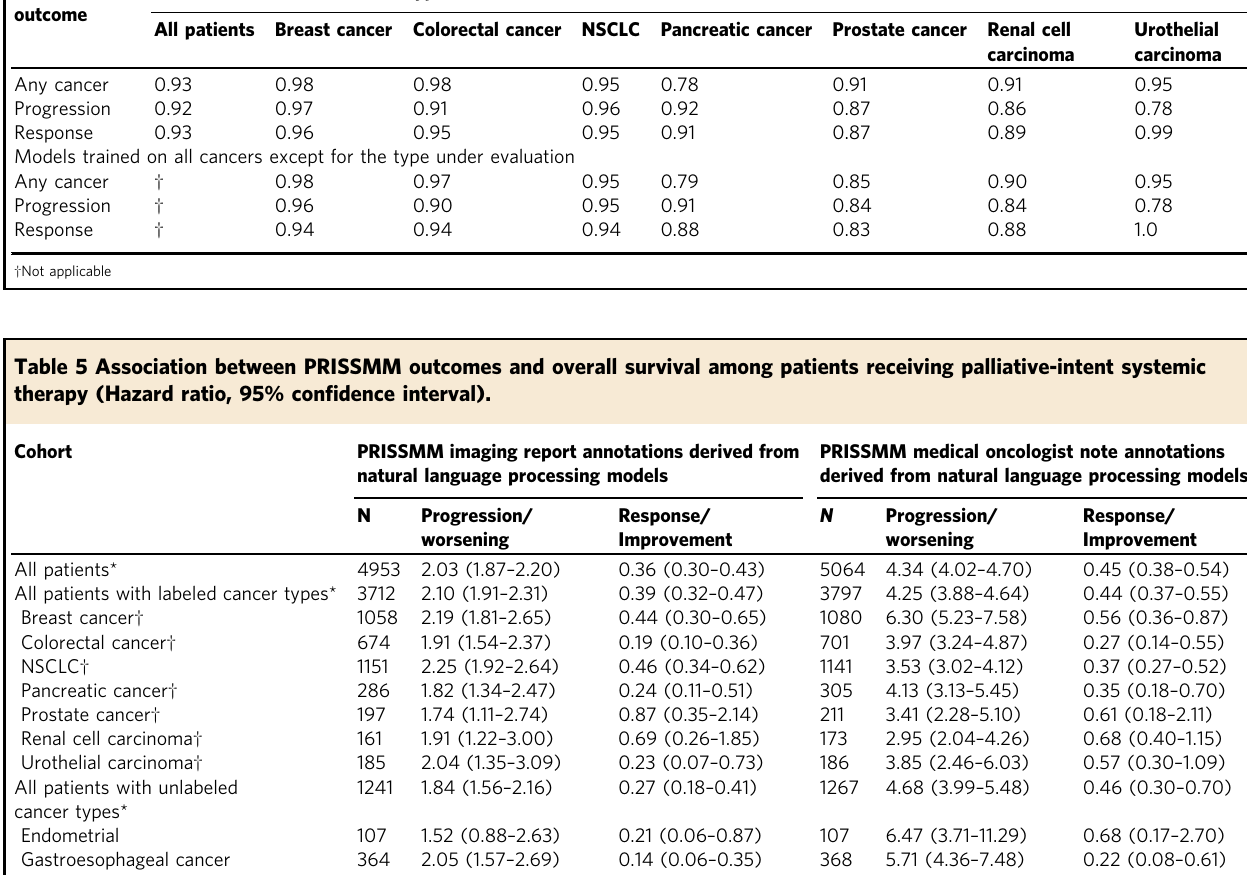
Table 4 Areas under the receiver operating characteristic curve (AUROCs) for NLP models that interpret medical oncologist progress note text to ascertain clinical outcomes, as evaluated in the labeled test set.